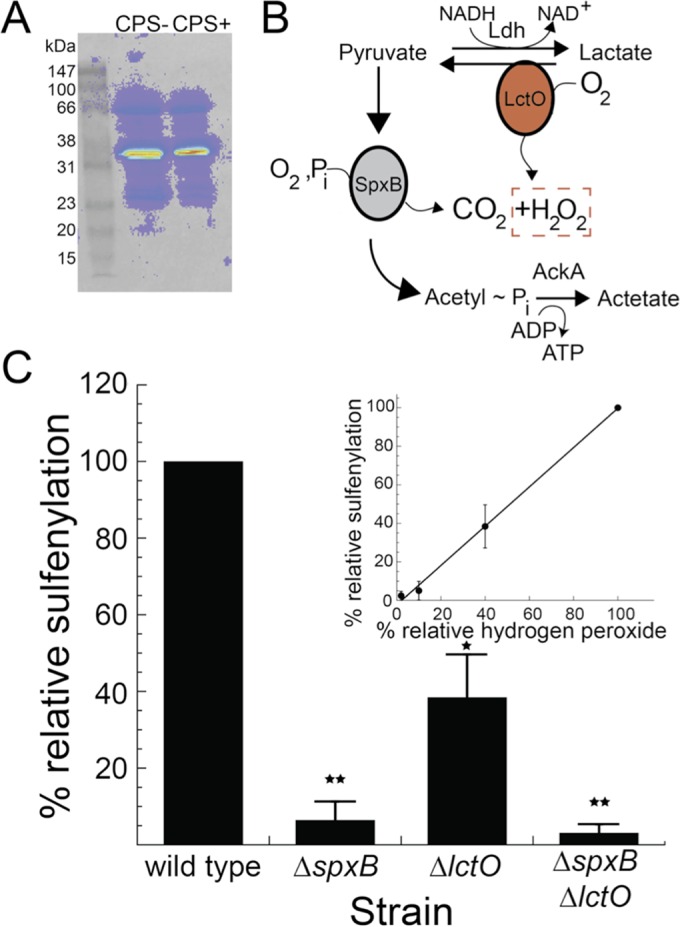
Proteome sulfenylation levels correlate with endogenous hydrogen peroxide (H2O2) levels in cells. (A) Representative sulfenylation profile of encapsulated (CPS+ [IU1781]) versus unencapulsated (CPS− [IU1945]) Streptococcus pneumoniae D39 (S. pneumoniae) strains grown in a rich medium (BHI) after labeling with 10 mM dimedone for 1 h in cell culture. Labeling was visualized using antibodies to 2-thiodimedone on soluble proteins via Western blotting. (B) Schematic illustration of hydrogen peroxide-generating enzymes in S. pneumoniae. SpxB, pyruvate oxidase; LctO, lactate oxidase; AckA, acetate kinase. (C) S. pneumoniae GapA sulfenylation is modulated by SpxB and LctO activity and correlates with the relative H2O2 concentrations (inset). *, P < 0.05, and **, P < 0.005, based on one-sample t test.